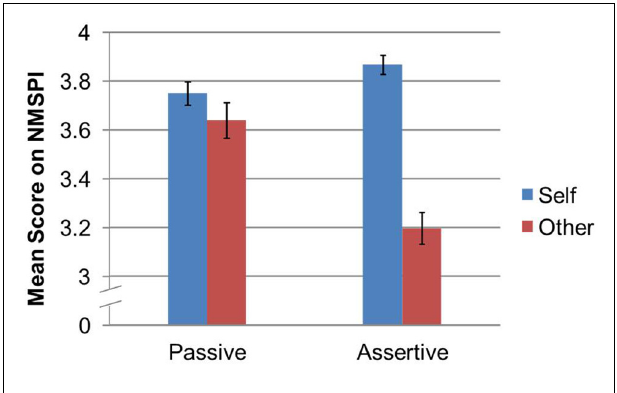
FIGURE 3 | Interaction between proxemic behavior condition and mean scores for self- and other-attributions as measured by the NMSPI.